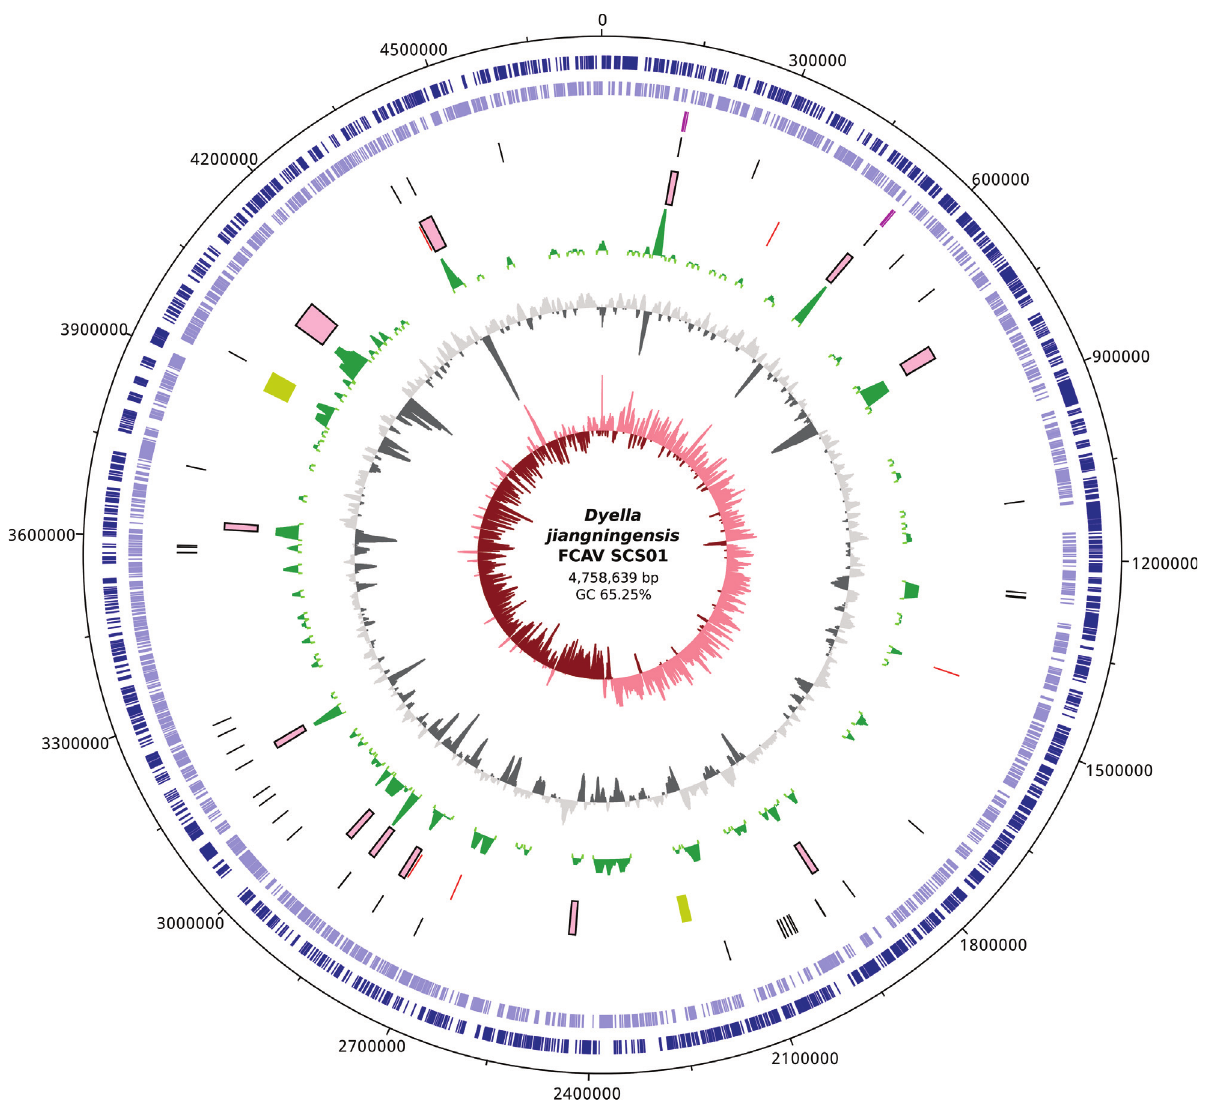
Figure 1 - Circular genomic representation of the Dyella jiangningensis FCAV SCS01. The inner red circle represents GC Skew. The second level circle in gray scale represents the GC%. The third level circle in green scale represents potential anomalous regions. The purple and yellow boxes represent genomic islands and prophage-like regions, respectively. The red, black and purple bars represent insertion sequences, tRNAs and rRNA operon regions. Genes are shown in the outer blue circle, whereas genes shown on the outside of the map are transcribed clockwise, while genes on the inside are tran- scribed